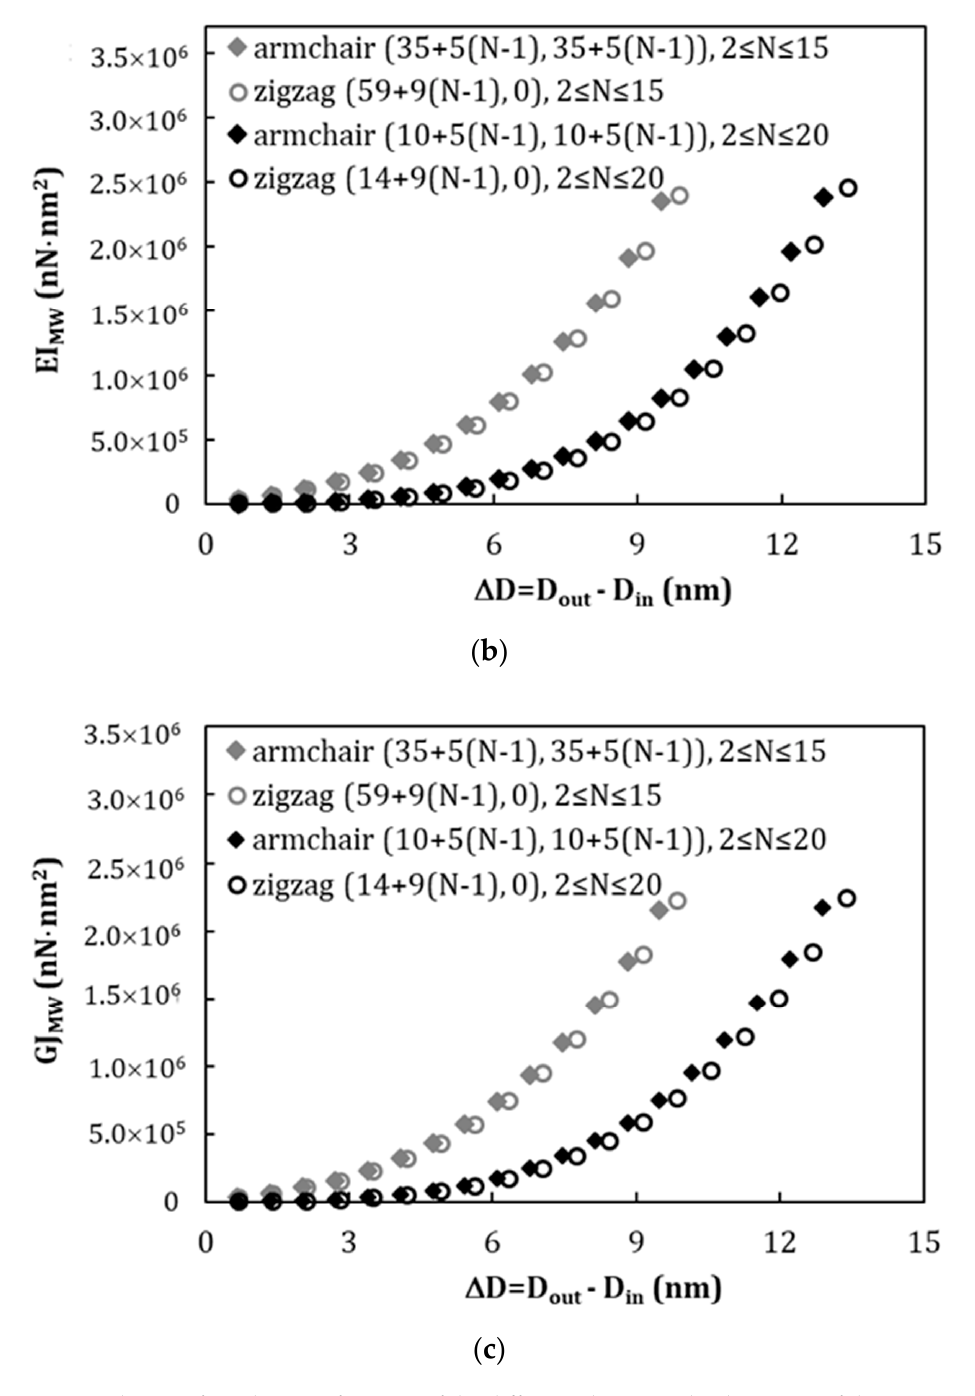
Figure 3. Evolution of rigidity as a function of the difference between the diameters of the outer and inner layers, ∆ D , for armchair and zigzag MWCNTs, in: ( a ) tension, EA MW , ( b ) bending, EI MW , and ( c ) torsion, GJ SW .